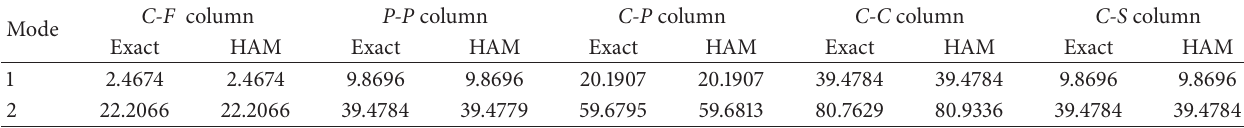
Table 2: Comparison of exact and HAM solutions of the buckling loads for 𝛽 = 0 with ten iterations.